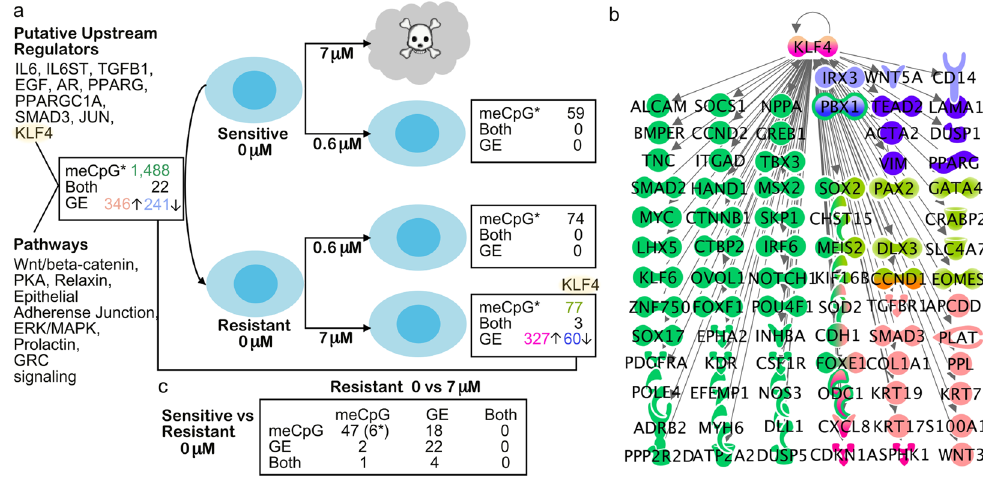
Figure 2. Integrative analysis of DNA methylome, transcriptome and functional enrichment data. ( a ) In the figure are the numbers of differentially expressed genes (GE), differentially methylated CpG sites (meCpG) and their overlap (both) between cisplatin sensitive and resistant cells (M019i) before cisplatin treatment (0 μ M), and changes detected in response to drug treatment. The putative upstream regulators with gene expression changes and canonical pathway enrichments common for both DNA methylome and transcriptome data are shown in the ( b ) Gene expression changes, DNA methylation changes or both are shown for the known direct target genes of KLF4, in different comparisons as indicated by the color codes in ( a ). ( c ) Comparison of differences observed before cisplatin treatment and in response to 7 μ M cisplatin treatment of resistant cells as indicated in the figure. * indicates the number of differentially methylated sites: in integrative comparisons, the number of overlapping genes closest to differentially methylated sites is shown. The functional analyses and networks in the figure were generated by using Ingenuity Pathway Analysis (IPA ® ,